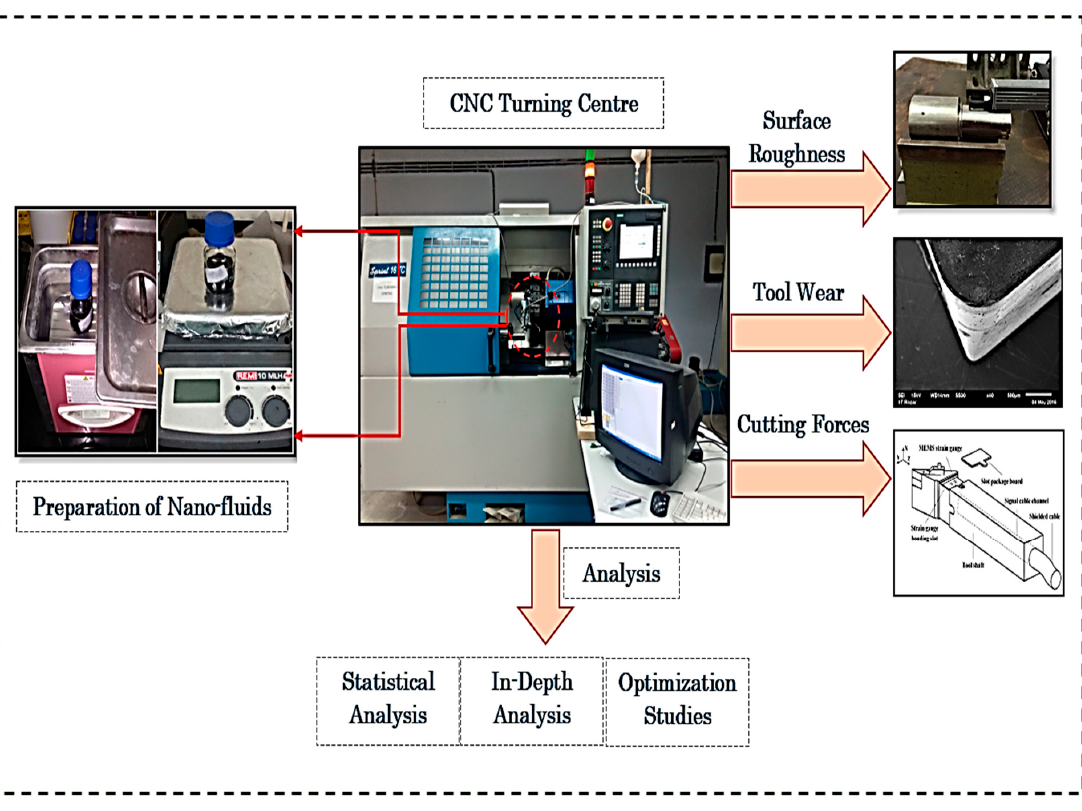
Figure 1. Research methodology of current work.